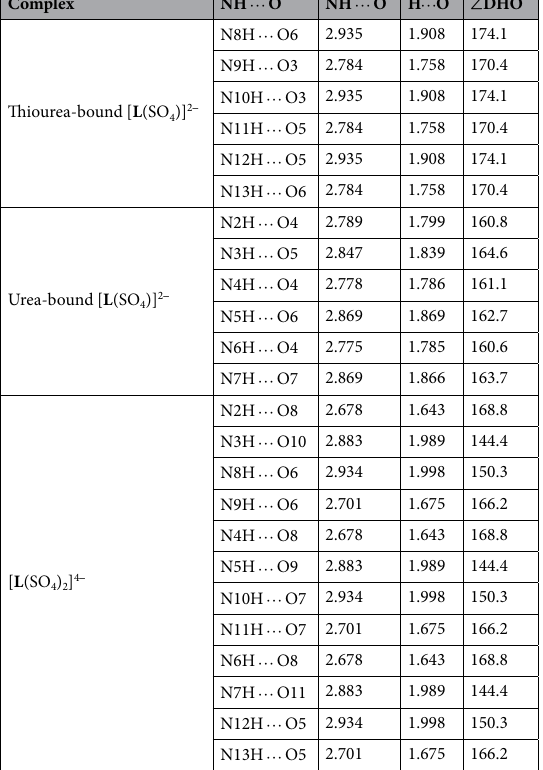
Complex NH  O NH  O H  O ∠ DHO